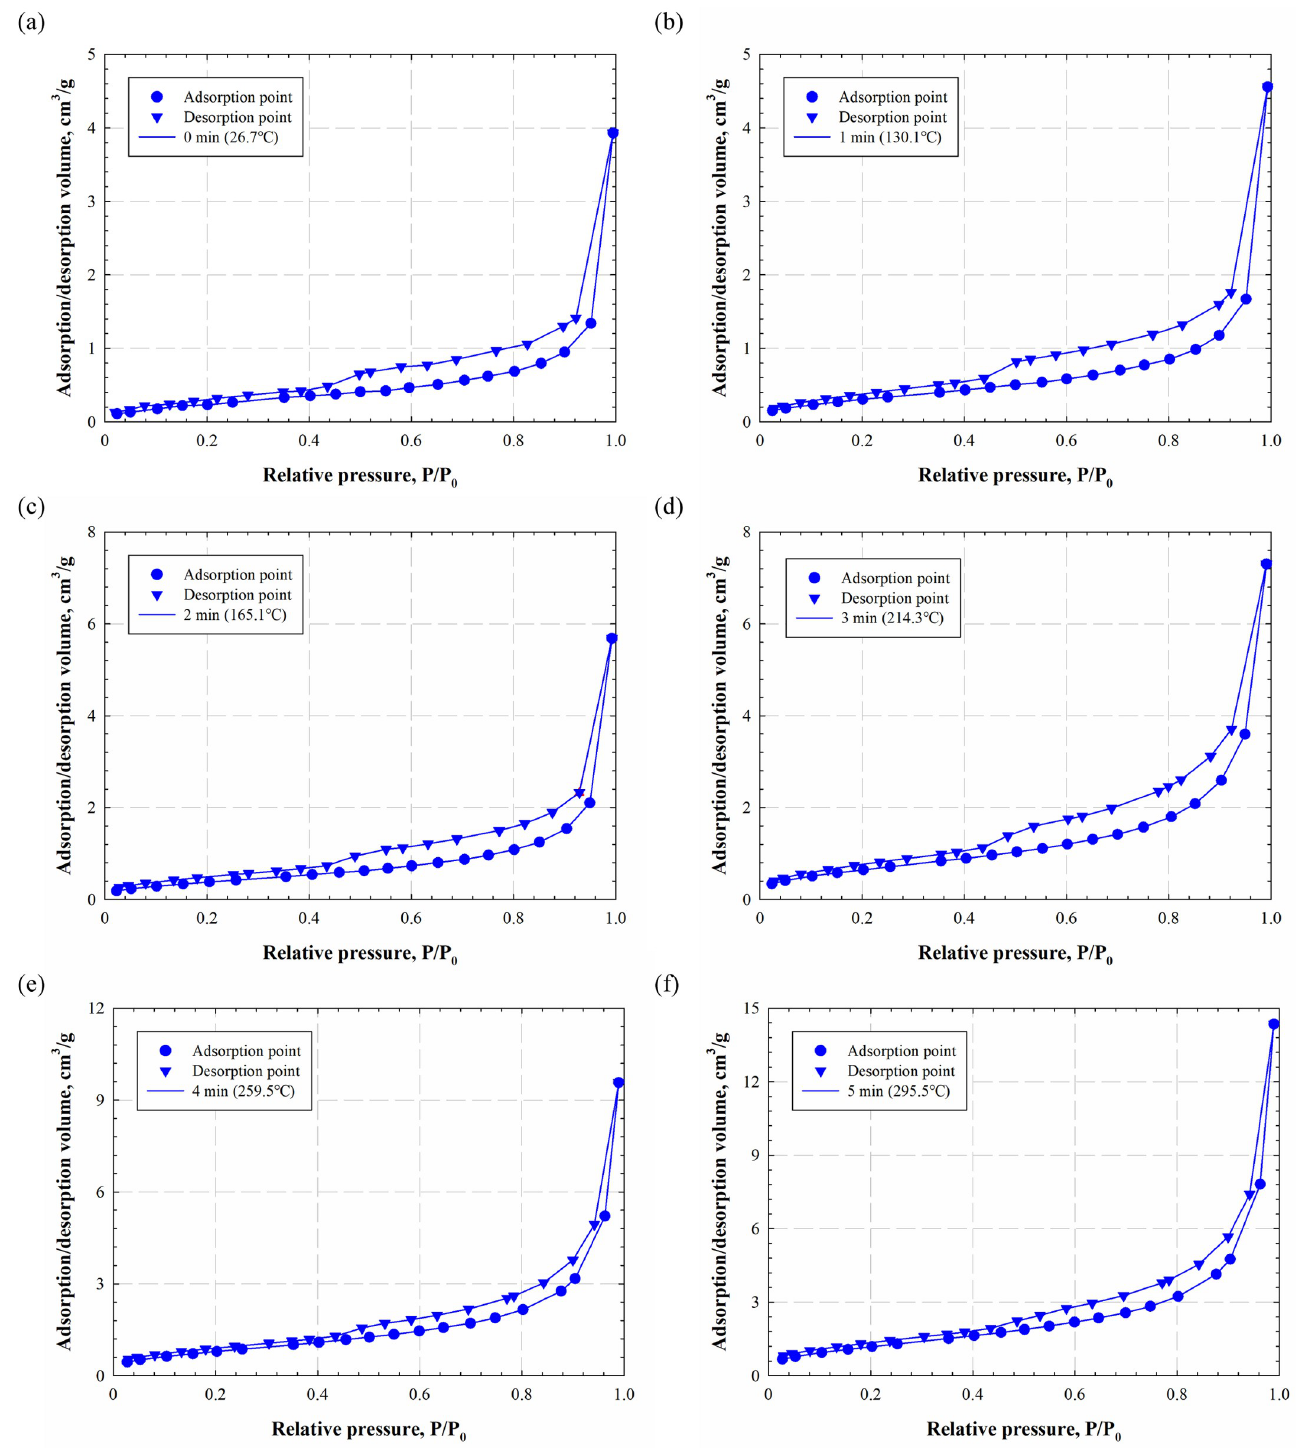
Fig 5. The adsorption/desorption isotherms of shale samples at different electromagnetic radiation times.